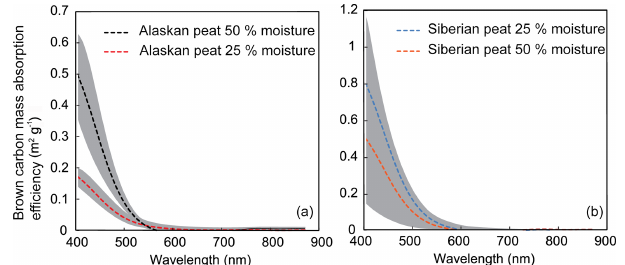
Figure 3. Wavelength-dependent mass absorption efficiency (MAE) of the sampled carbonaceous (brown) aerosols from (a) Alaskan and (b) Siberian peat smoldering combustion. The dashed lines show study-averaged values. The shaded bands cor- respond to error bars measured at 405, 532, 781, and 870nm, and connected by best-fit